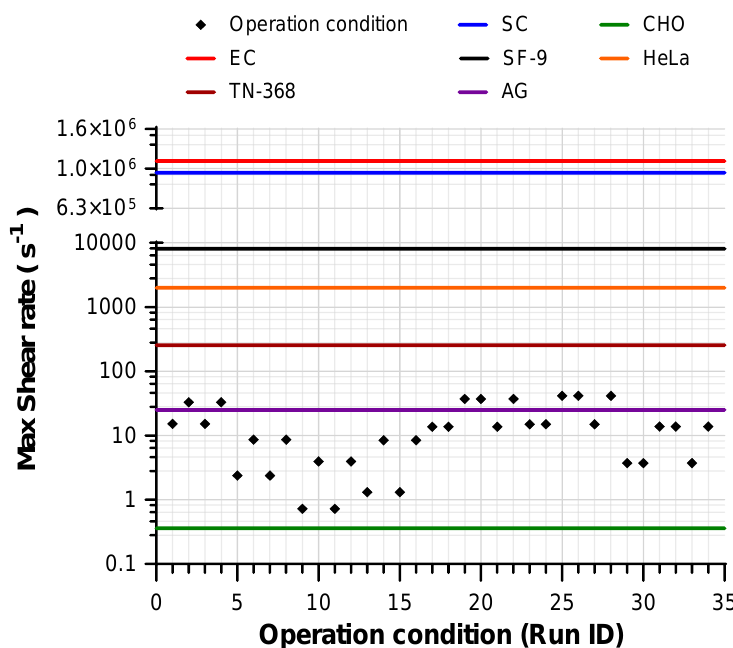
Figure 7. Shear rate values for each operation condition compared with the maximum shear rate of three di ff erent cell